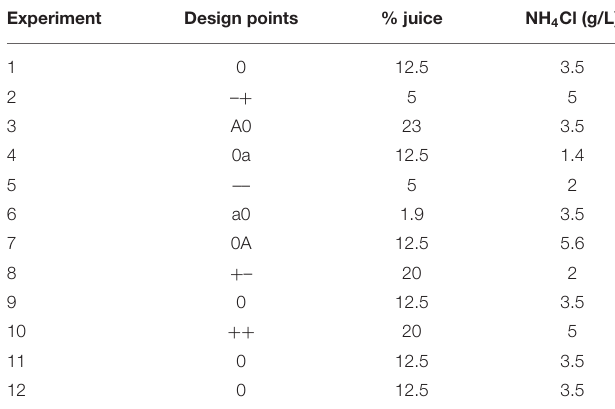
TABLE 1 | JBP percentages and NH 4 Cl concentrations evaluated by a central composite design for C. necator growth optimization.